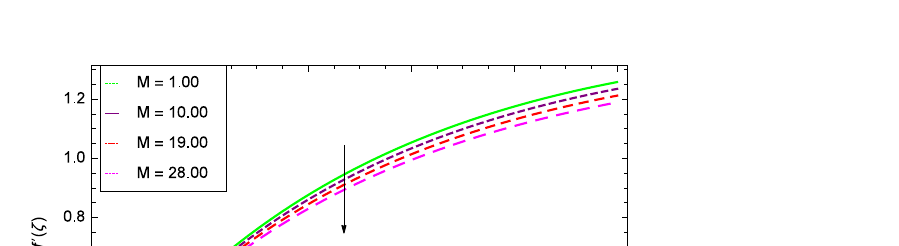
Figure 7. Parameter effect on velocity f ′ (ζ) profile.